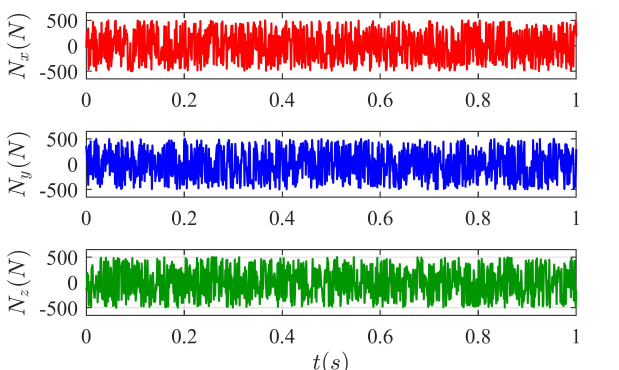
Figure 10. The external disturbance signals during 0–1 s.